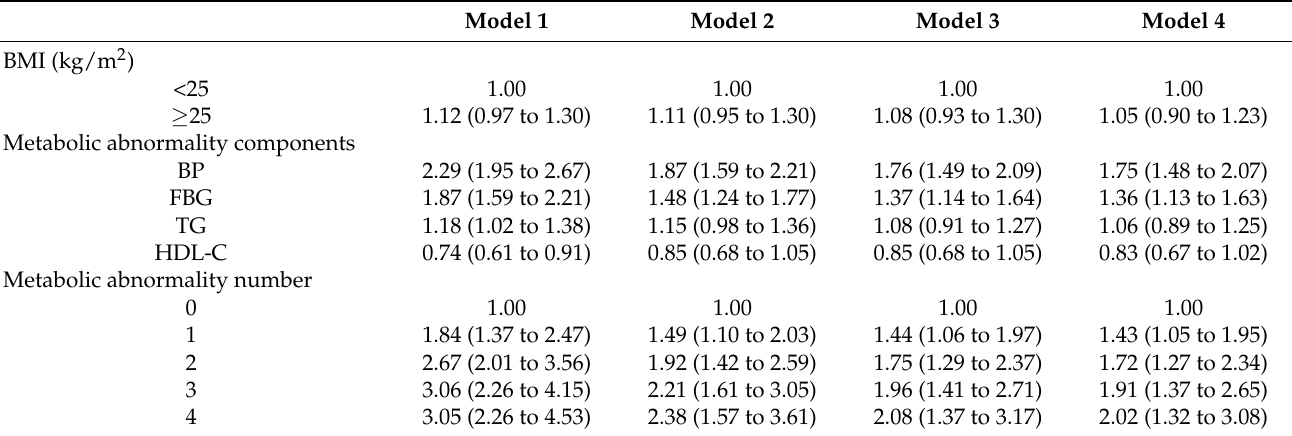
Table 3. Multifactorial logistic regression analyses for carotid plaque according to BMI, metabolic abnormality components, and metabolically healthy status.